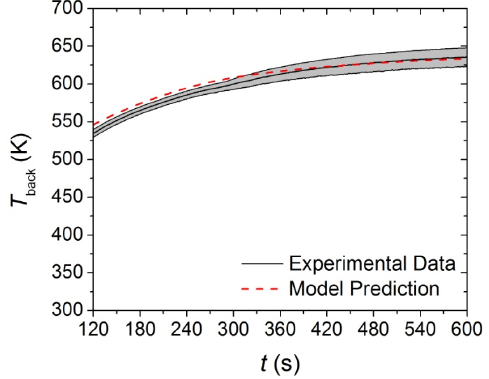
Figure 12. Final 480 s of experimental T back curve measured in CAPA tests and corresponding model predicted curve for the upper layer exposed to a radiant flux of 30 kW·m − 2 . The shaded region corresponds to two standard deviations of the mean experimental data.